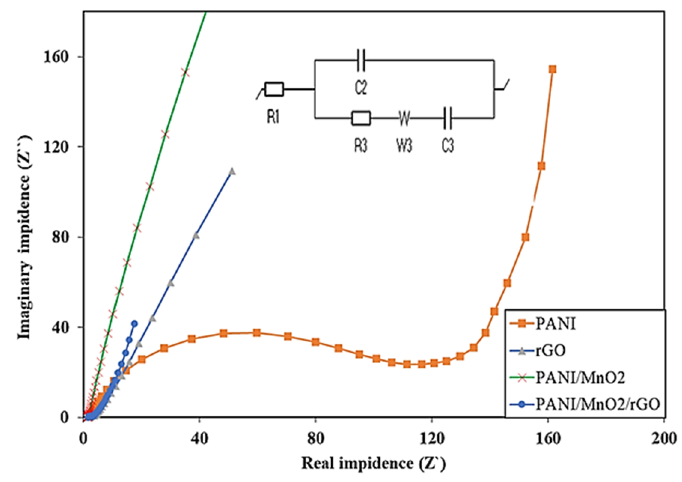
Figure 9. Nyquist plots of PANI, rGO, α -MnO 2 /PANI and α -MnO 2 /PANI/rGO.